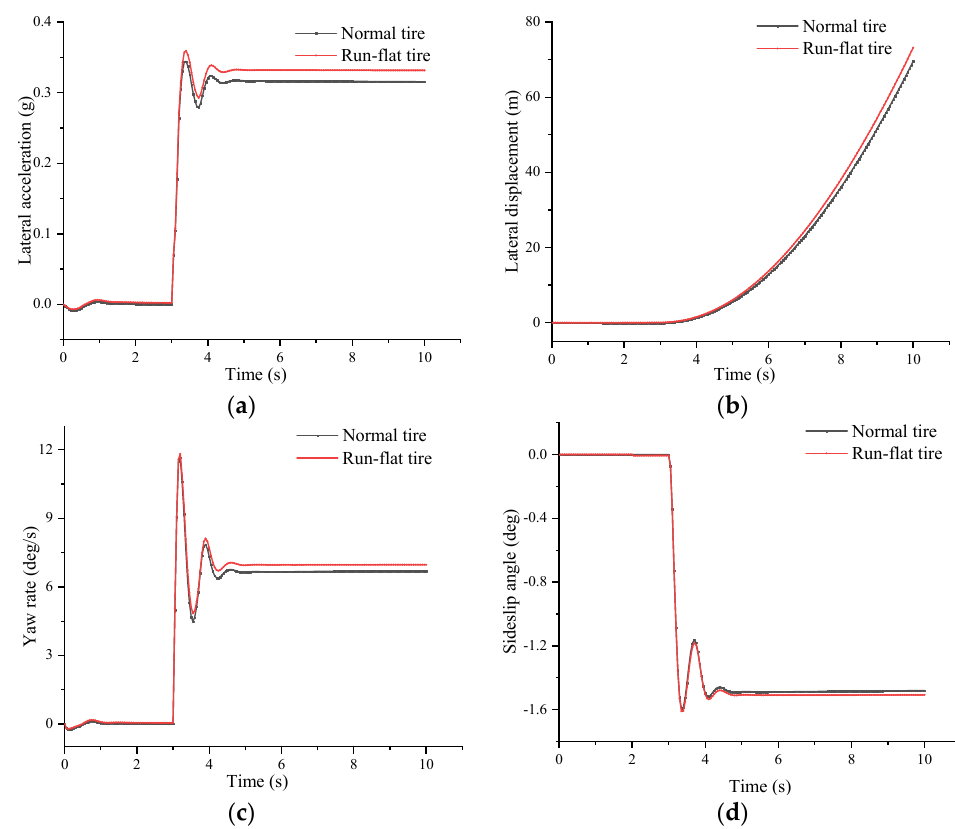
Figure 4. The simulation curve of left front tire blowout: ( a ) lateral acceleration curve; ( b ) lateral displacement curve; ( c ) yaw rate curve; ( d ) sideslip angle curve.